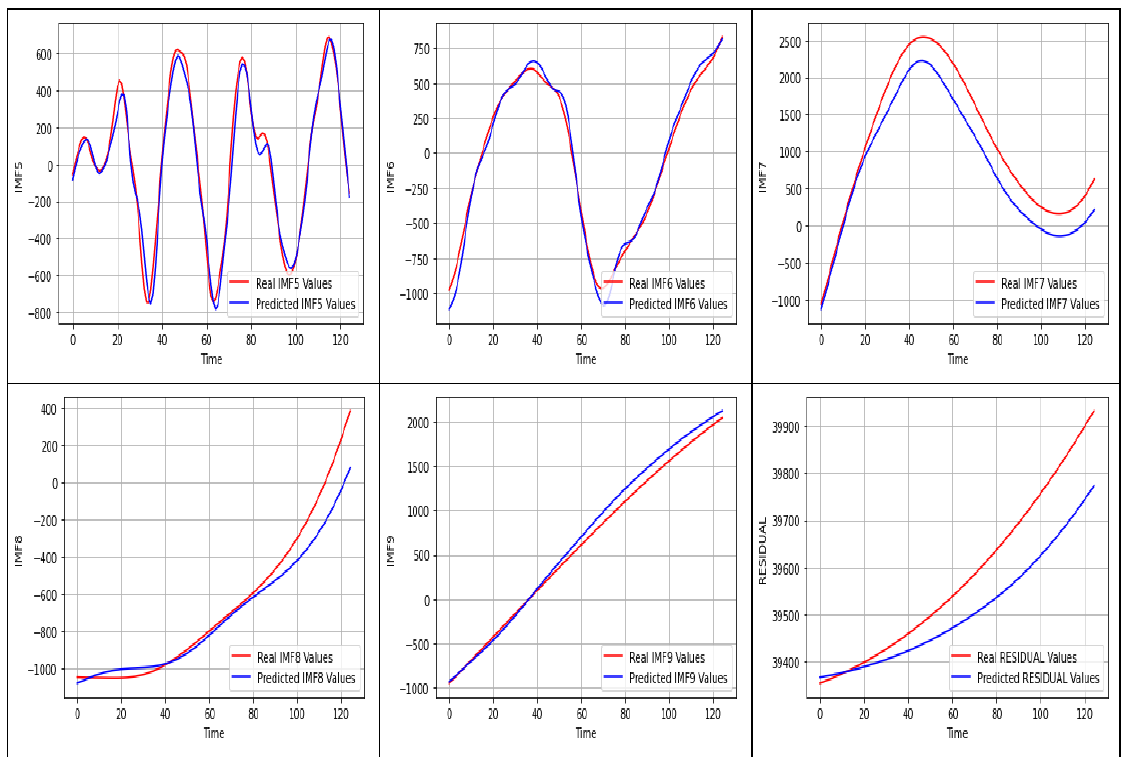
Figure 9. Predicted results of correlated subcomponents obtained from the proposed Akima-EMD- LSTM model.